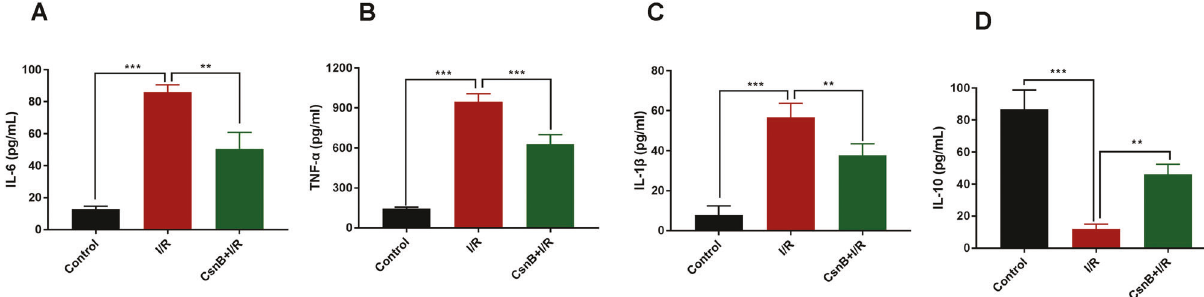
Fig. 6 CsnB alleviates in fl ammatory responses post-I/R in vivo. A – D Pro-in fl ammatory and anti-in fl ammatory cytokine secretions were identi fi ed via ELISA. n = 3. Data are the mean ± SD. ** P < 0.01, *** P <